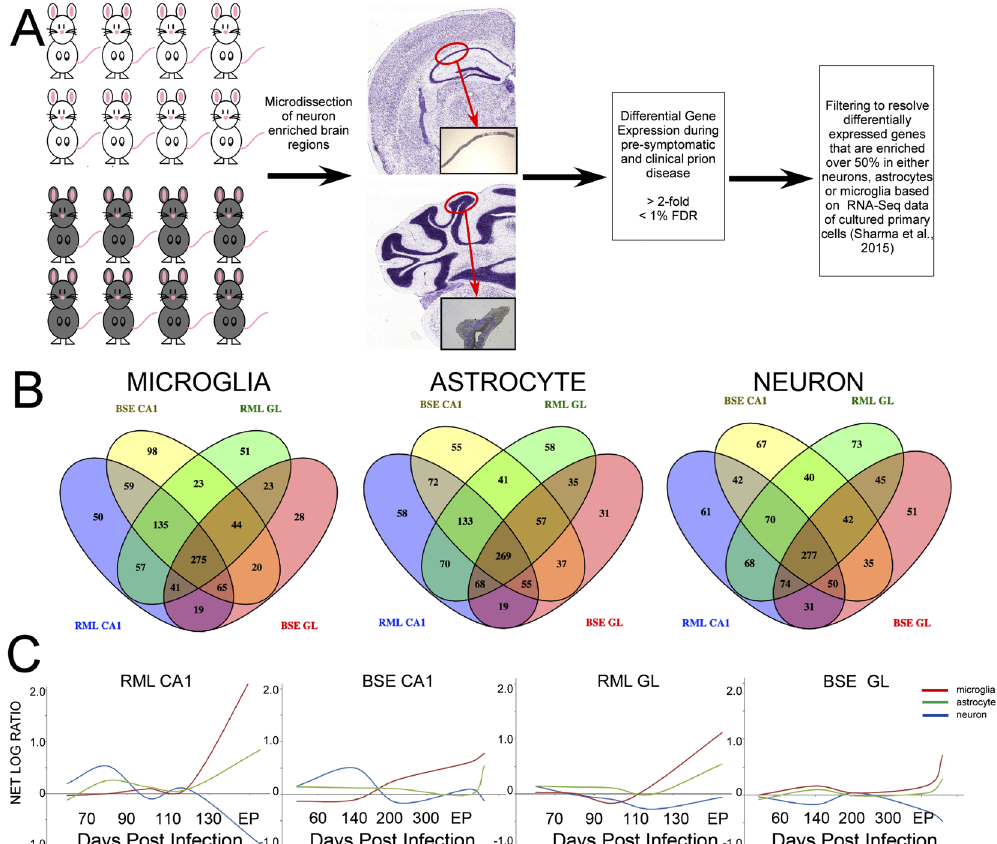
Figure 1. Gene expression dynamics in two regions of mouse brain infected by RML scrapie or BSE prions. ( A ) Schematic illustration of the workflow for the removal of the tissue region of interest and prion strain– resolved temporal transcriptome. ( B ) Venn diagrams illustrating the overlap of differentially expressed genes across excised hippocampal CA1 and cerebellar granule layer regions from mice infected with RML scrapie and BSE prion strains. Diagrams depict comparisons made for microglia-, astrocyte- and neuronal-enriched genes (from left to right). ( C ) Trends in the net temporal expression profiles of microglia- (red), astrocyte- (green), and neuron-enriched genes (blue) across each tissue region and prion strain.